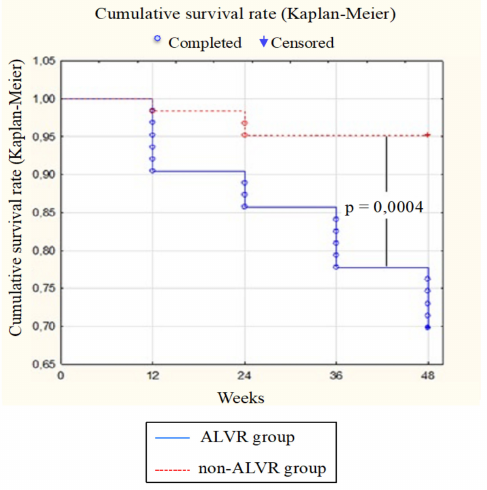
Figure 4. The incidence of hard endpoints in the comparison groups.